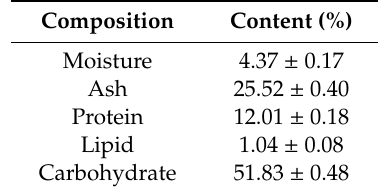
Table 1. The proximate composition of Ecklonia maxima.